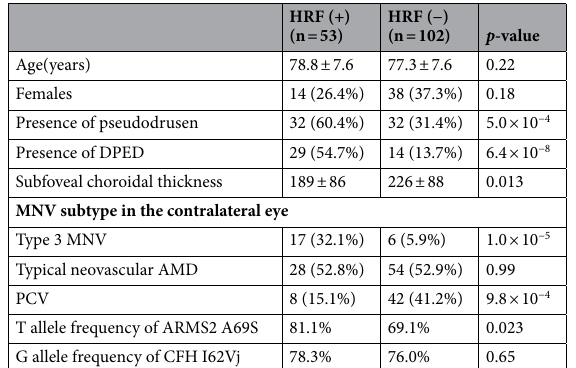
Table 2. Comparison between eyes with and without hyperreflective foci. HRF, hyperreflective foci; DPED, drusenoid pigment epithelial detachment; MNV, macular neovascularization; RAP, retinal angiomatous proliferation.